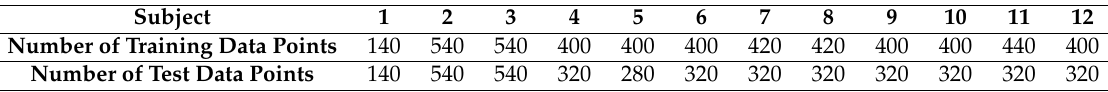
Table 1. Summary information of the data for 12 subjects from BCI Competition II, III, and